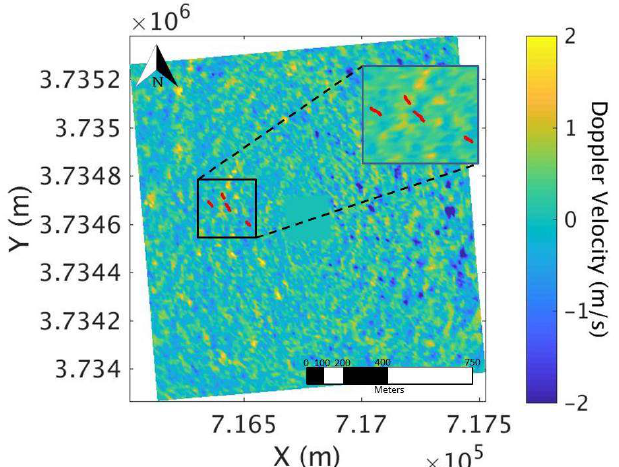
Figure 1. Tracks from the four GPS wave buoys in the radar field of view during collection of radar dataset 1 are shown in red, overlaid on an example frame of Doppler velocity data. The black box shows a zoom-in of that area.